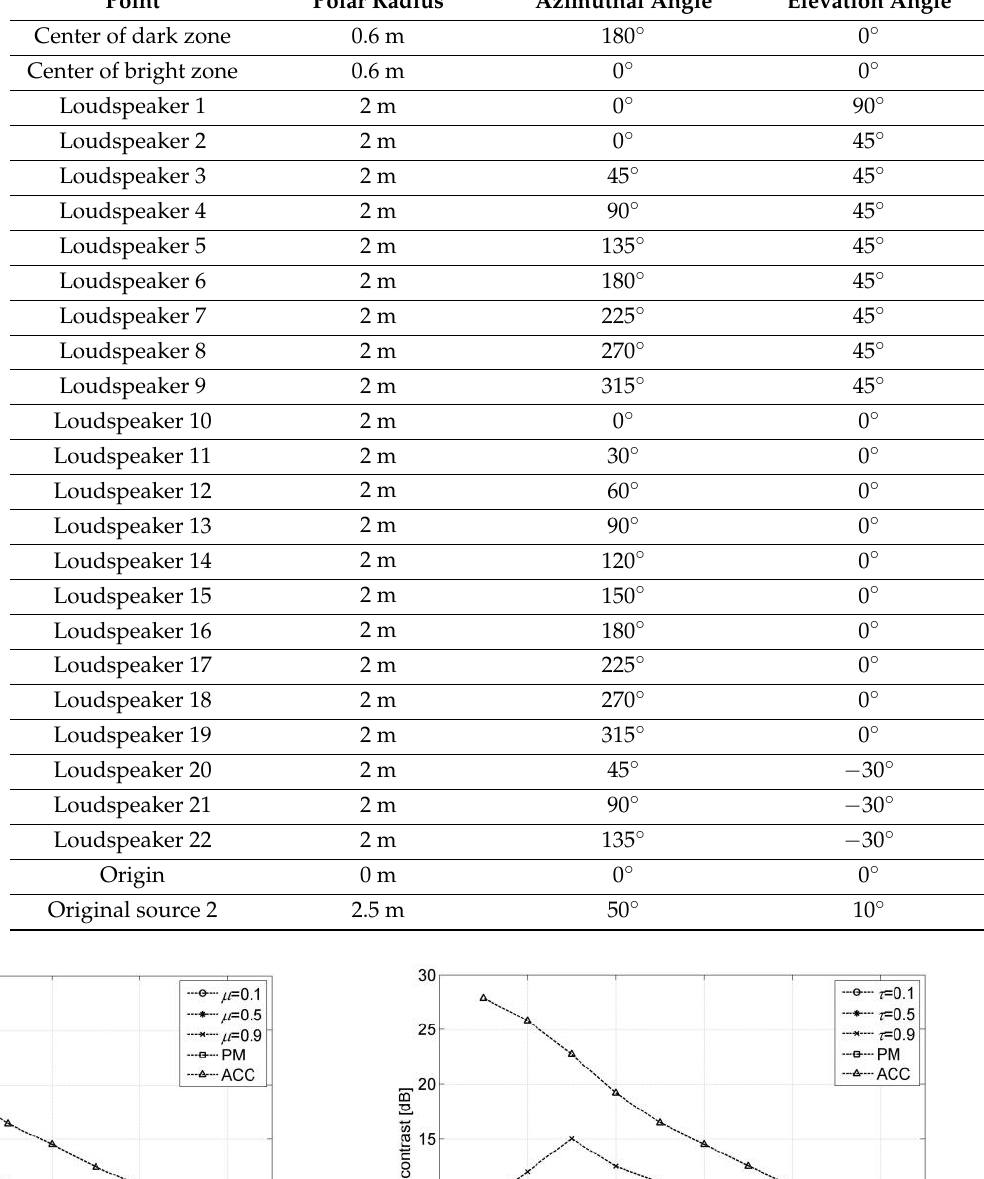
Table 2. The location of related points for experiment 2.